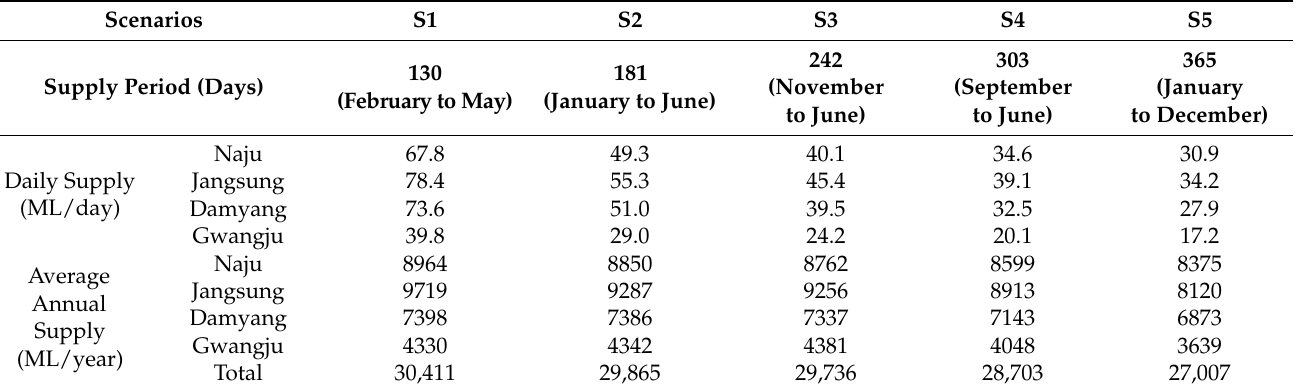
Table 4. Simulated EF supply potential of the study